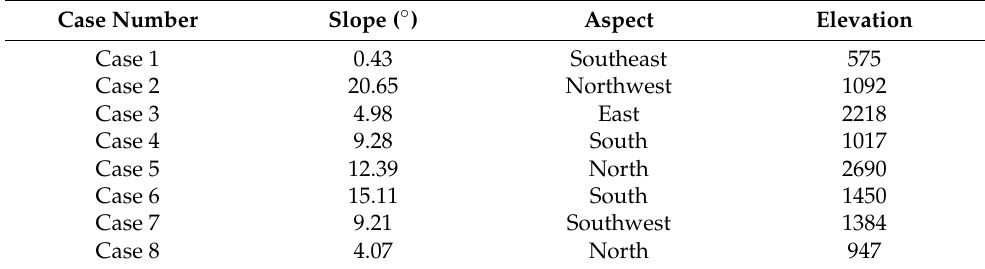
Table 4. Eight cases of forest and grassland fire topographic